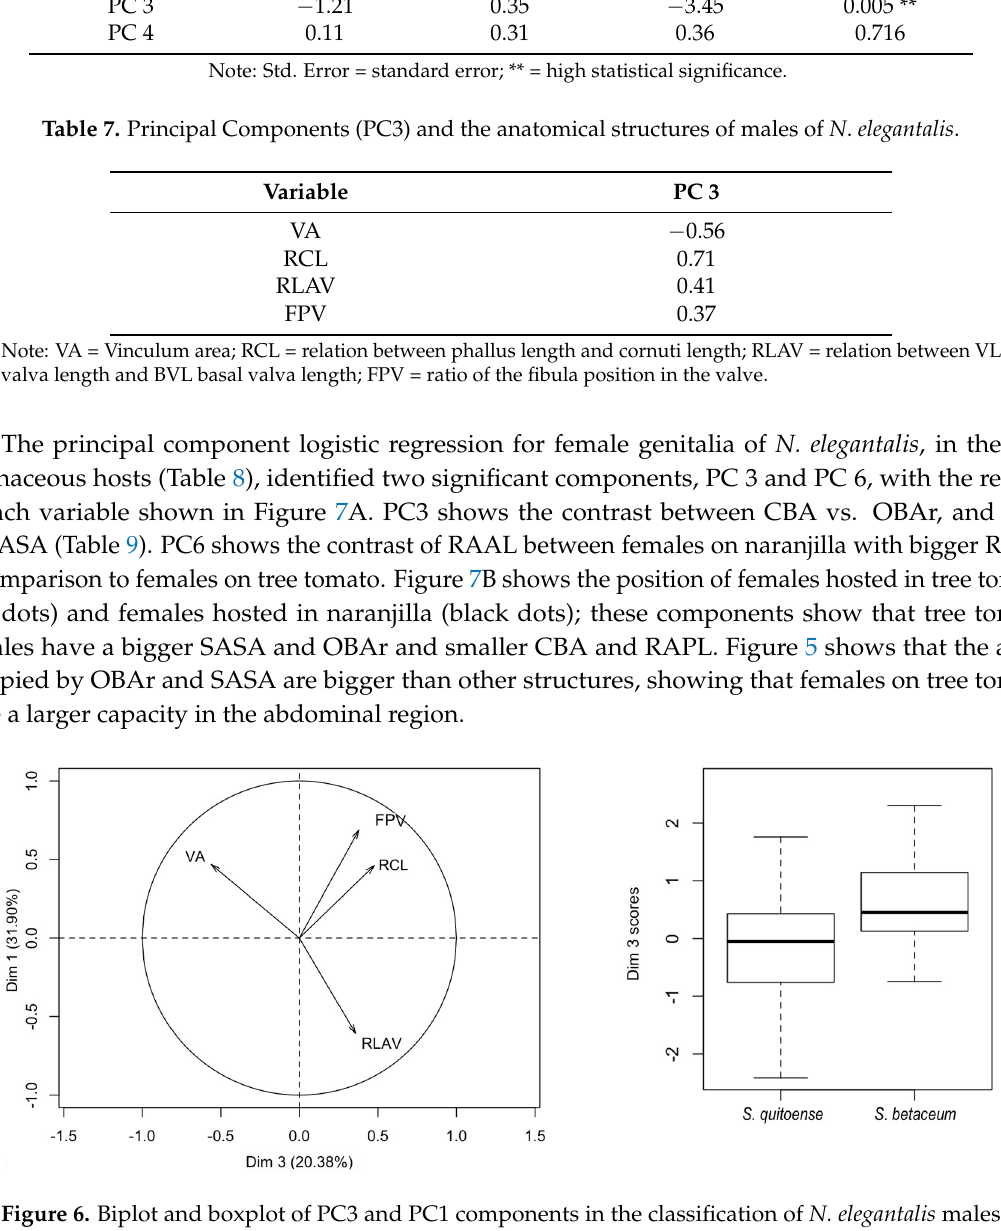
Figure 6. Biplot and boxplot of PC3 and PC1 components in the classification of N. elegantalis males hosted in two Solanaceae families ( S. quitoense and S. betaceum ). Table 8. Logistic regression estimates between the classifications components of N . elegantalis females–host plant and the size of the Principal Component structures.